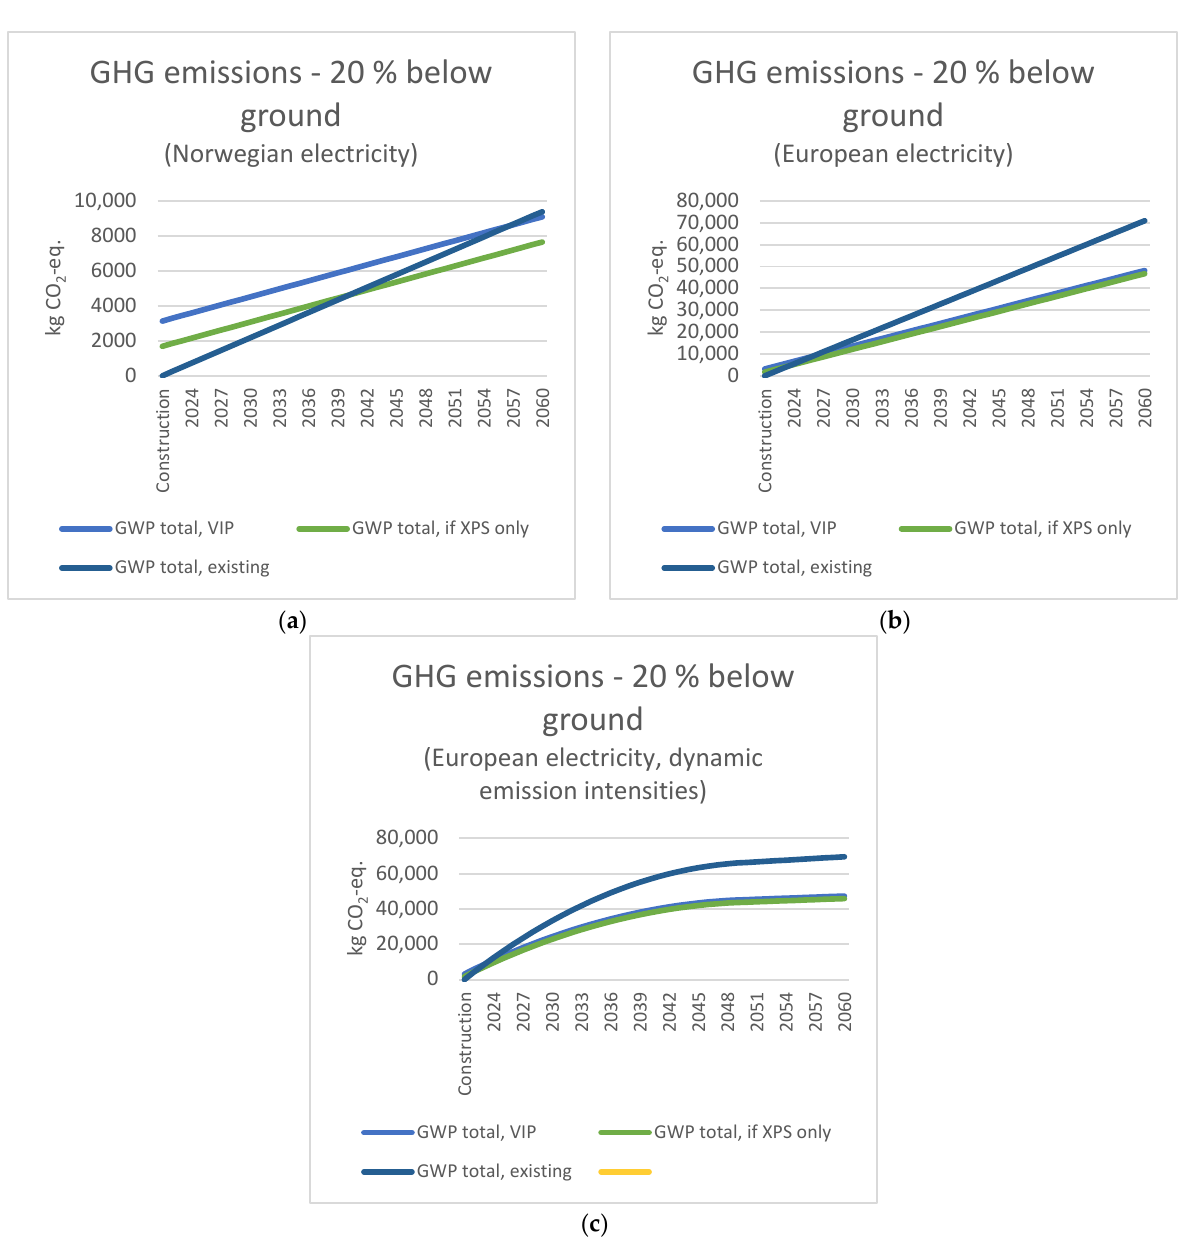
Figure 7. ( a ) GHG emissions for light-weight aggregate wall, Norwegian electricity mix (18 g CO 2 -eq. per kWh); ( b ) GHG emissions for light-weight aggregate wall, European electricity mix (136 g CO 2 -eq. per kWh); ( c ) GHG emissions for light-weight aggregate wall, European dynamic emission intensity (starting at 318 g CO 2 -eq. per kWh in 2022 and declining to 24 g CO 2 -eq. per kWh from 2050 and onwards).